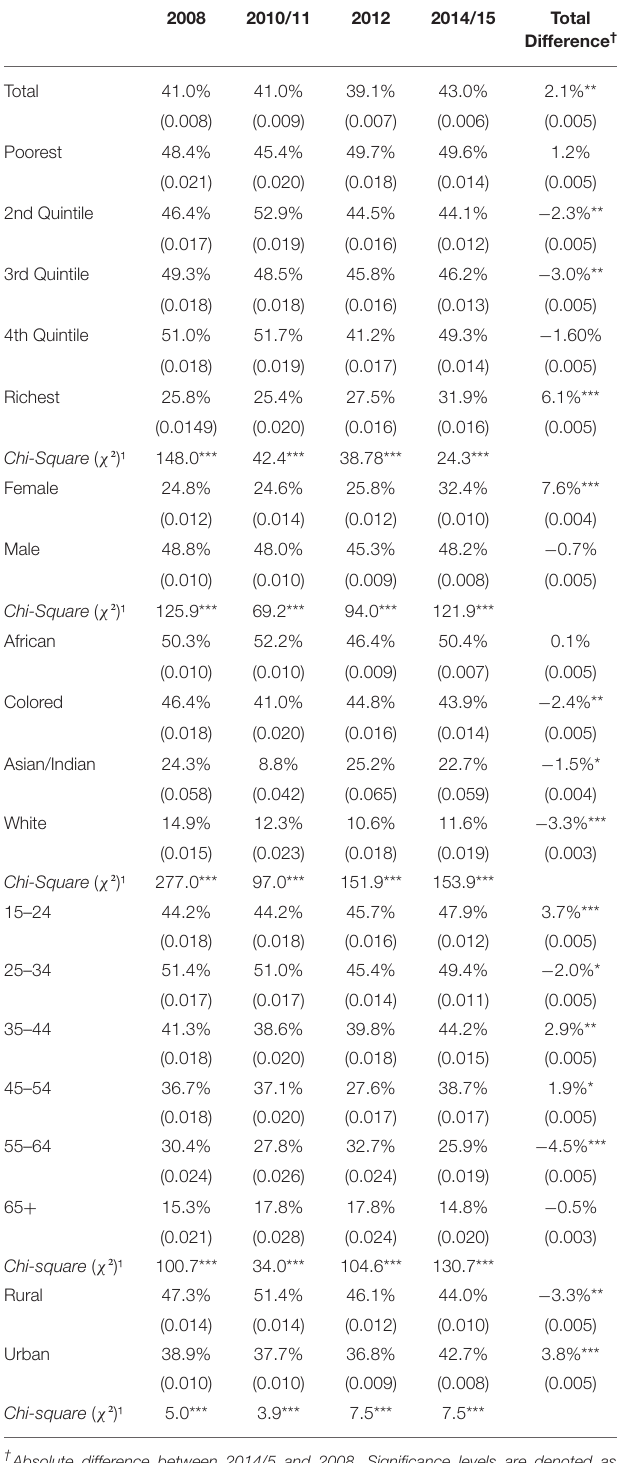
TABLE 4 | Prevalence of binge drinkersª in SA from 2008 to 2015 by SES and other equity